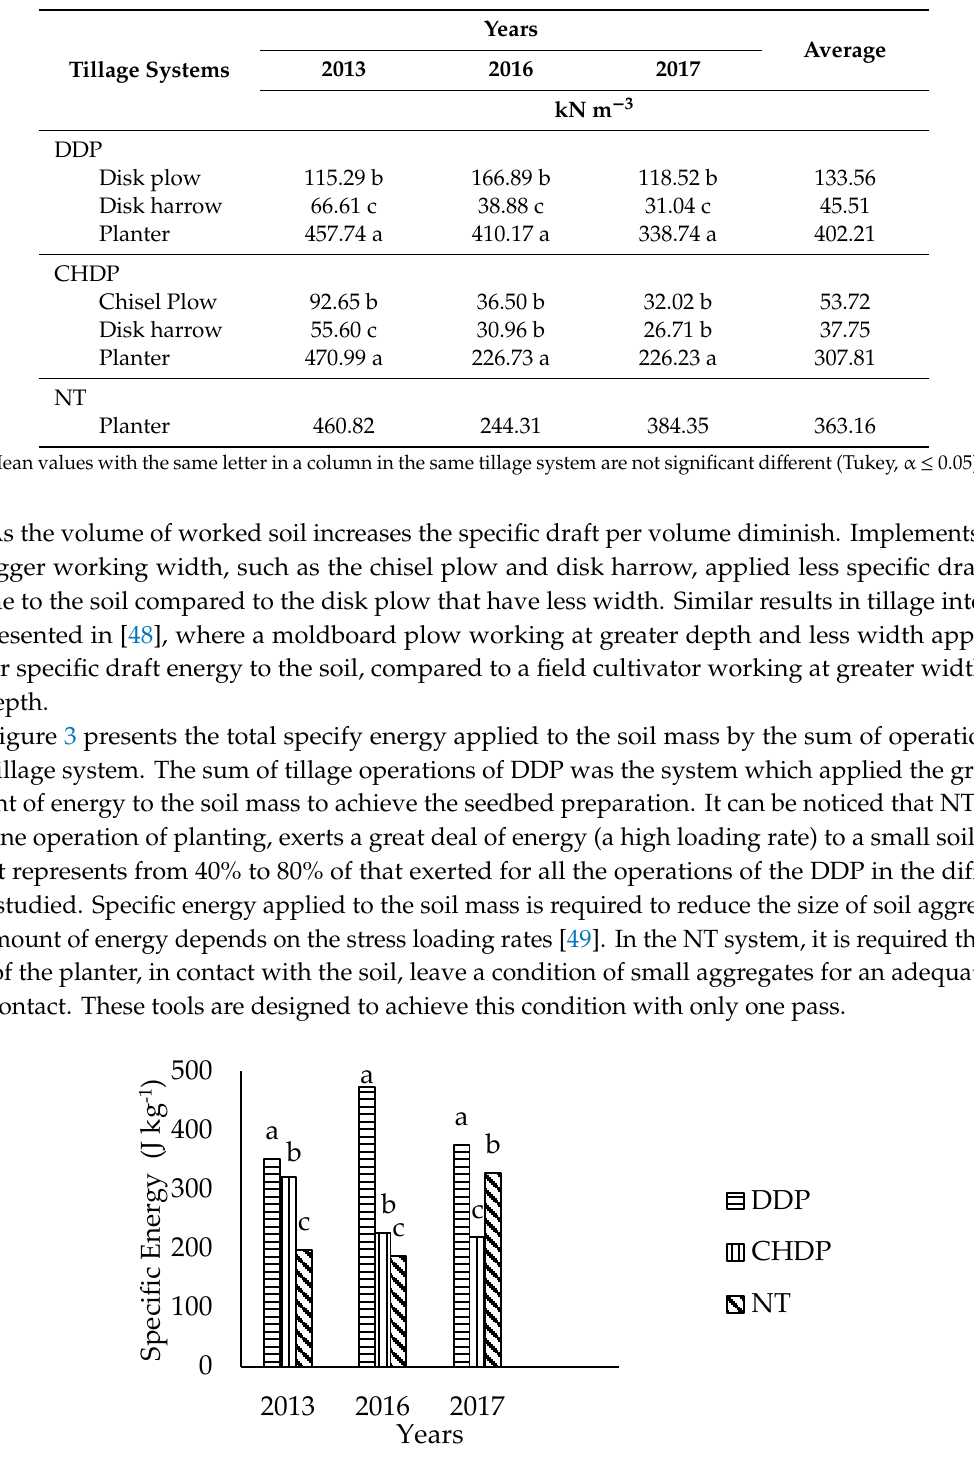
Figure 3. Specific energy applied to the soil mass for each tillage energy; different letters in columns in the same year are significantly different (Tukey, α ≤ 0.05).